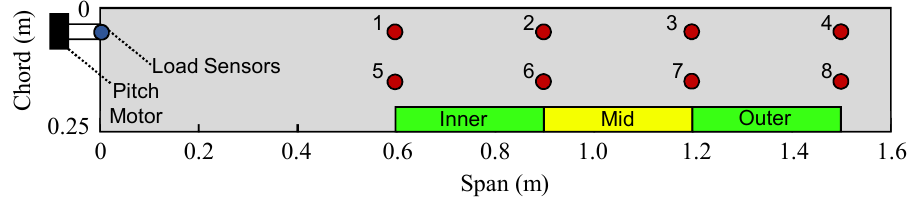
Figure 3. Schematic top-view illustration of the wing with three control surfaces, eight acceleration sensor locations, pitch motor and load sensor location.